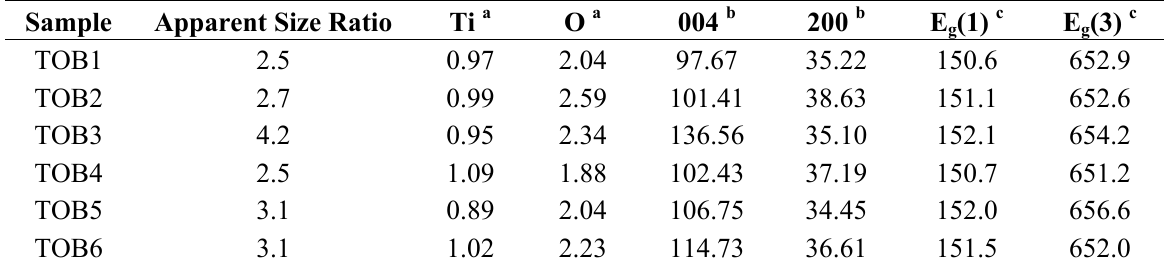
Table 2. XRD parameters of TiO representative peaks of